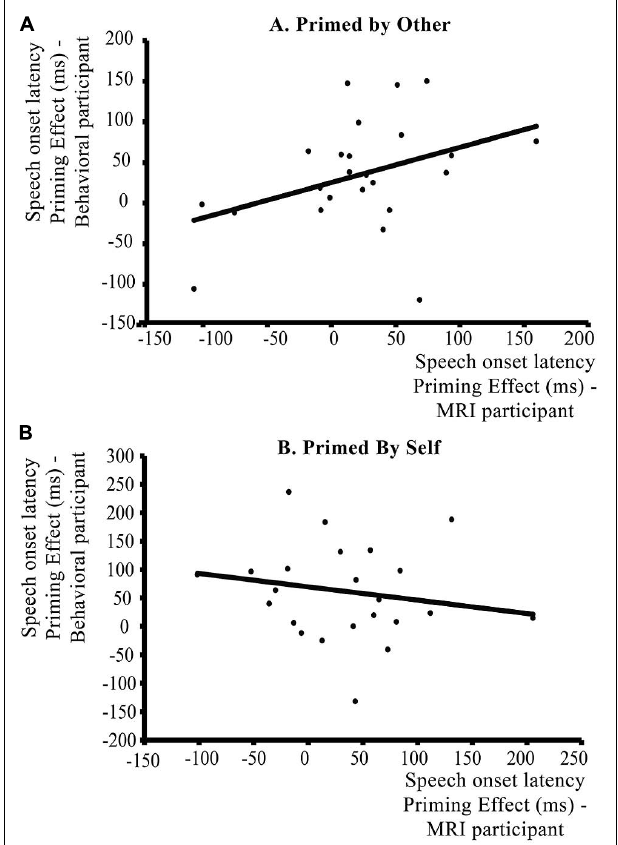
FIGURE 6 |Within-context analysis: correlation between individual magnitudes of syntactic priming effects (repeated – novel syntax) in speech onset latencies (ms) for the participants in the communicative context. The y axis represents the average syntactic priming effect of the behavioral participant, the x axis the average syntactic priming effect of the participant in the MRI scanner. Priming effects are spit according to Speaker Switch: (A) shows the correlation between priming effects when participants are primed by their partner (Speaker Switch – comprehension to production priming), (B) shows the correlation for trials where participants are primed by themselves (No Speaker Switch/production to production priming).When primed by the other participant, there is a positive correlation between the priming effects of participants in